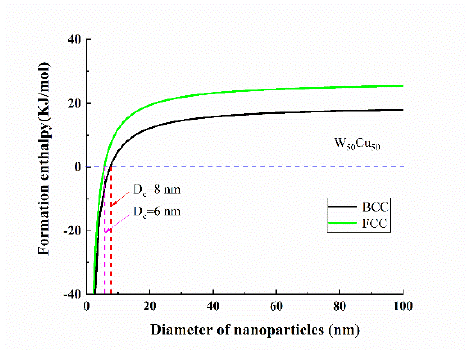
Figure 3. Formation enthalpy of W50Cu50 nanoparticles with different crystalline structure as the function of particle size, where d WCu = ( d W + d Cu )/2 = 0.2668 nm.